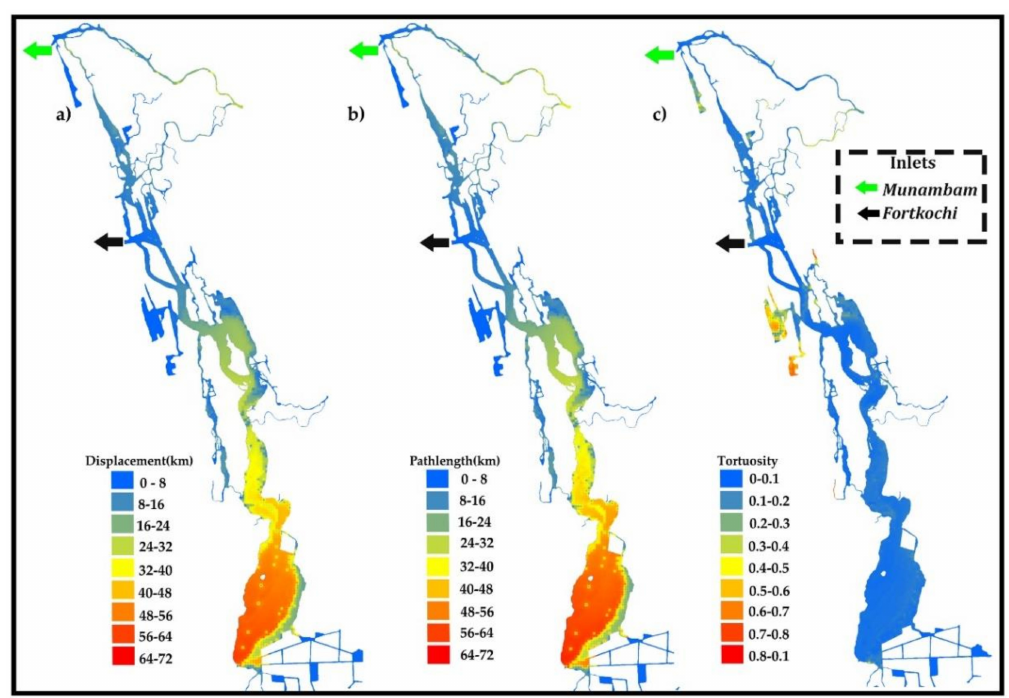
Figure 18. Displacement ( a ), path length ( b ) and tortuosity ( c ) of the CE during the control run simulation with Case 1 (river ON and tide OFF